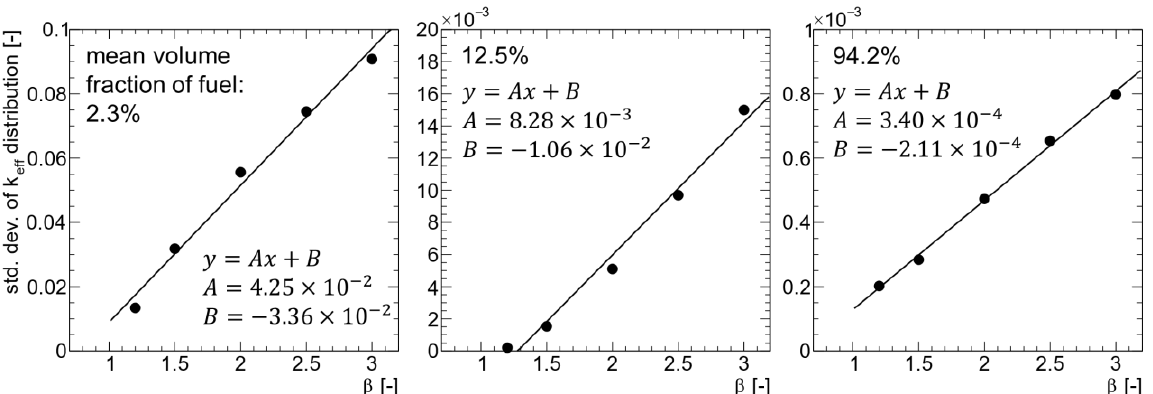
Figure 4. Standard deviation of the k distribution for different mean volume fraction of fuel. The eff fitting results by linear functions are also shown. Left, center, and right figures correspond to the cases that the mean volume fraction of fuel are 2.3, 12.5, and 94.2%,